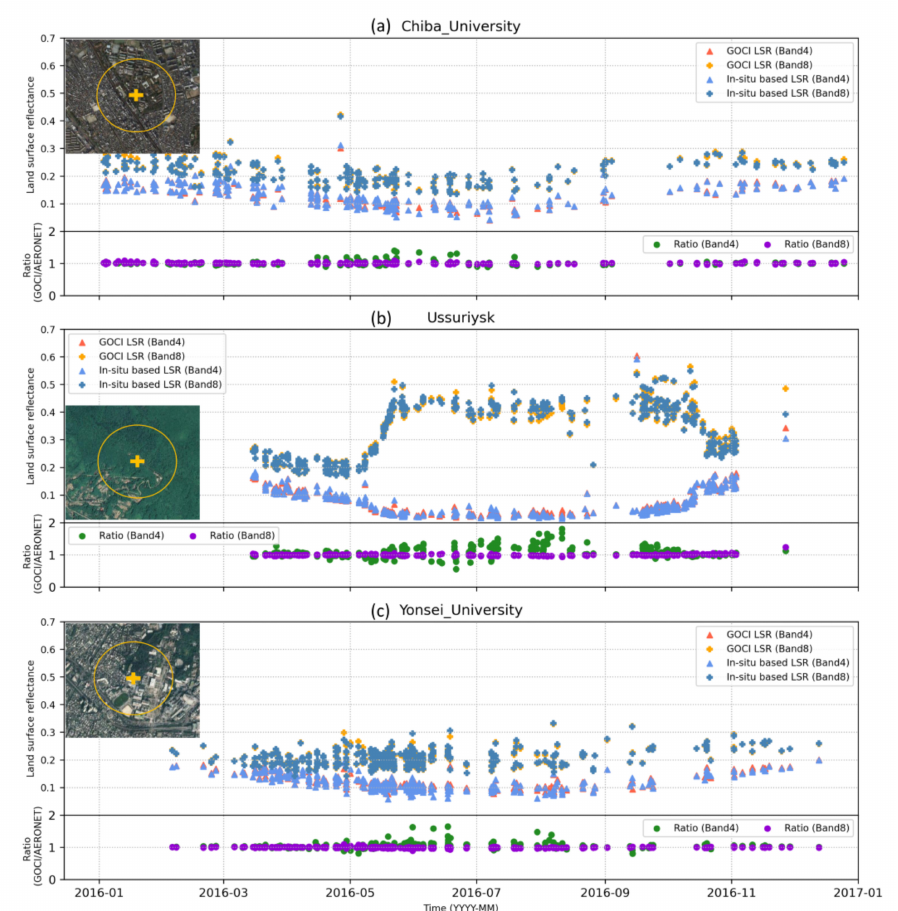
Figure 6. Time series of GOCI LSR (triangle) and in situ reference LSR (plus symbol) for bands 4 (red and blue) and 8 (orange and navy) for three sites with different land types: ( a ) urban, ( b ) vegetation cover, and ( c ) mixed. The RGB images in each figure were obtained from Google Map. The orange plus symbol and circle indicate locations of ground observations and a radius of 500 m, respectively. The green and purple circles in plots below each figure indicate ratio of GOCI to AERONET LSR for band 4 and 8, respectively.